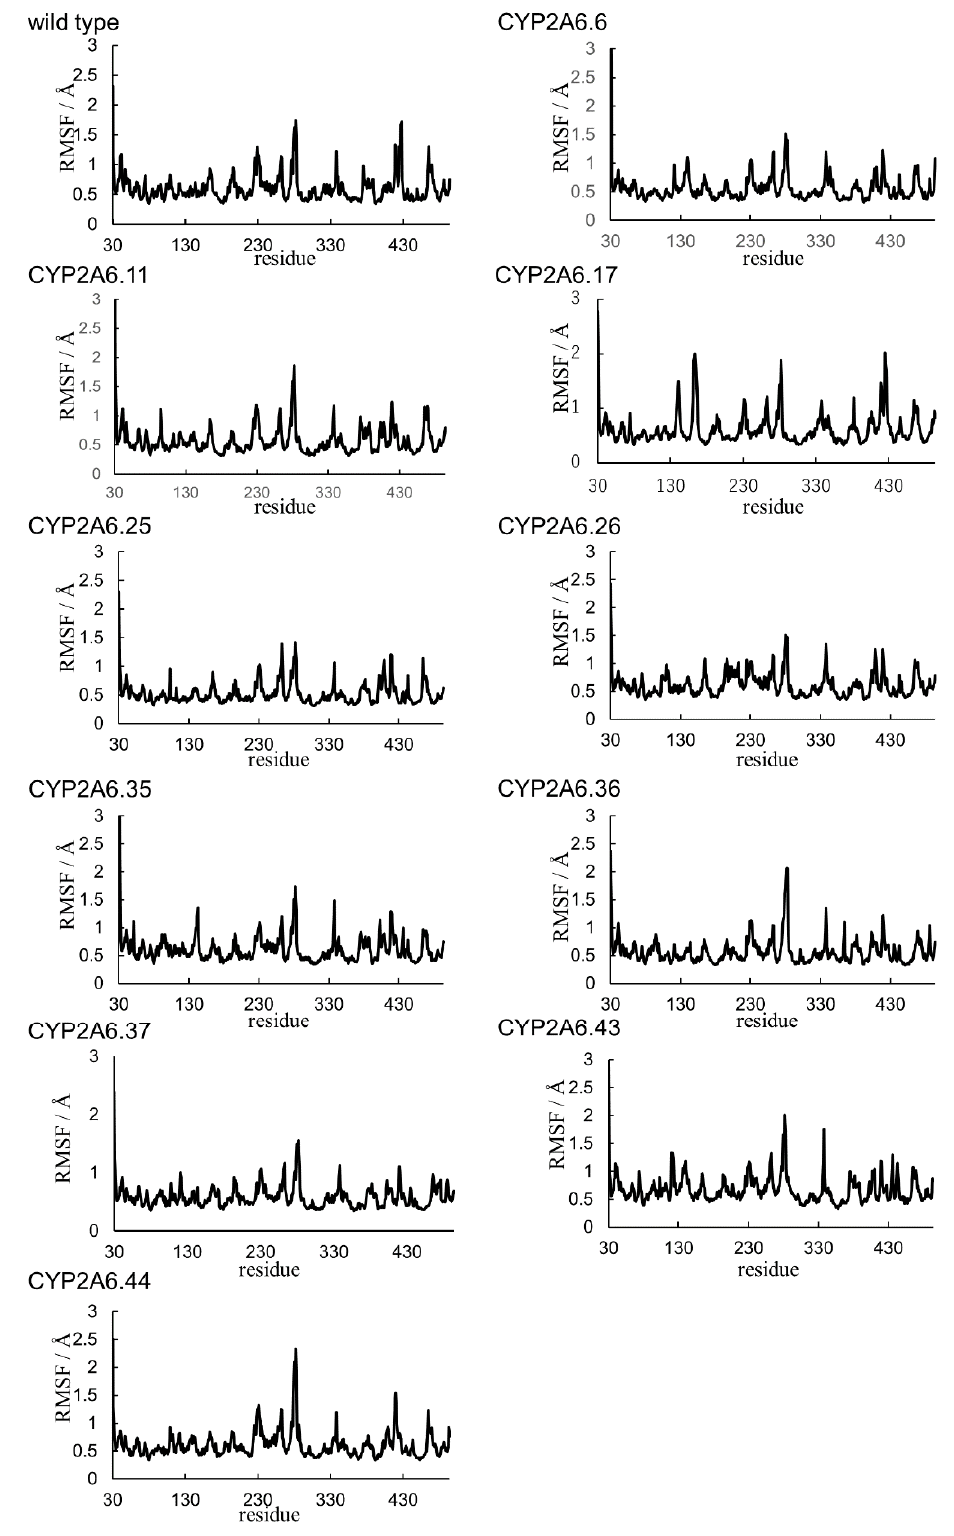
Figure 4. RMSF plots of Cα atoms in the last 10 ns of simulations.